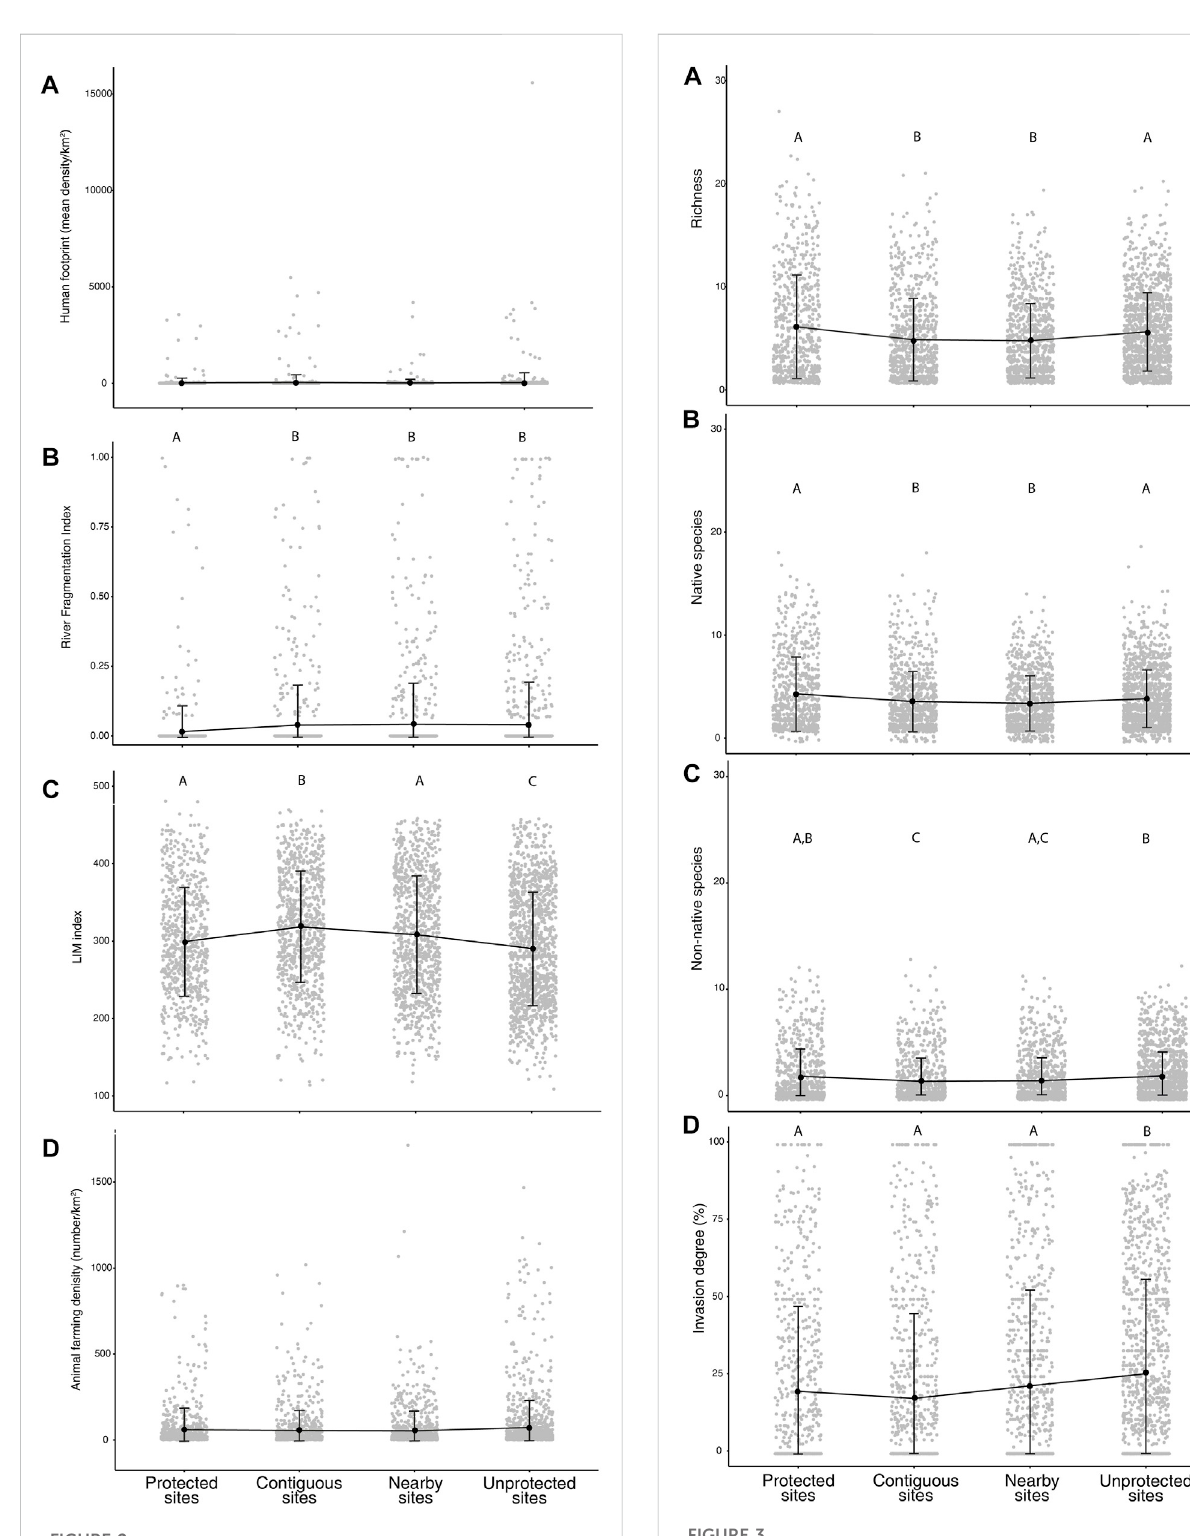
FIGURE 3 Mean values (black points) and standard deviations (vertical bars) of richness (A) , number of native species (B) , number of non-native species (C) and percentage of invasion degree (D) for Protected, Contiguous, Nearby, and Unprotected sites. Capital letters show the results of the Dunn ’ s test, having different letters indicating signi fi cant difference ( p <